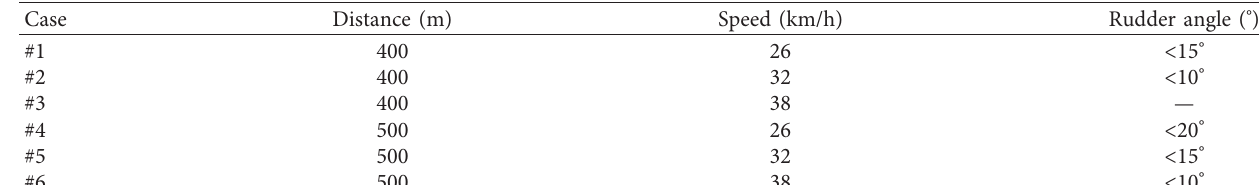
Table 10: Ship track forecast operating